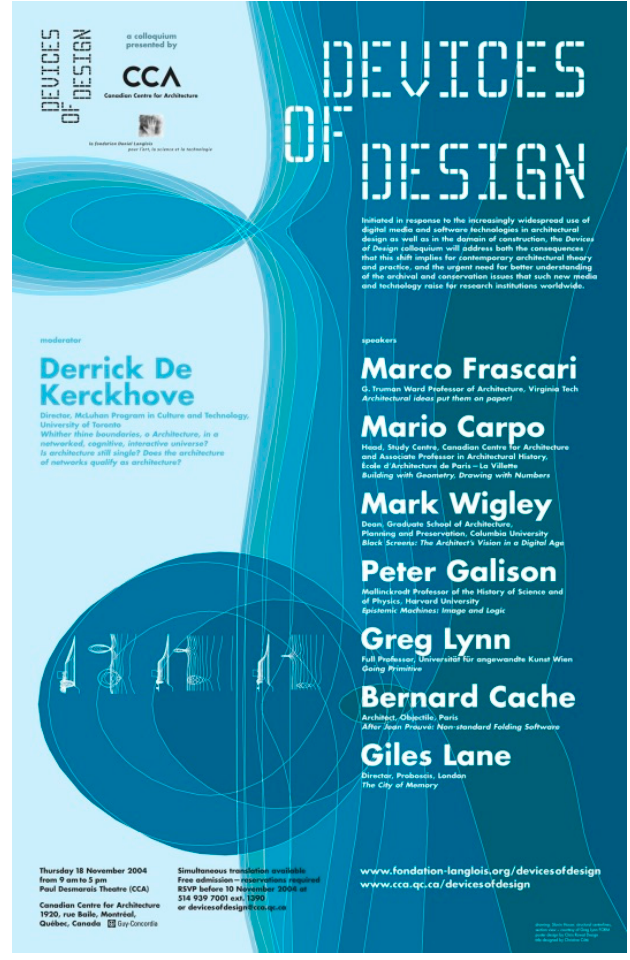
Figure 1. A poster for the Devices of Design event. © Fondation Langlois and CCA